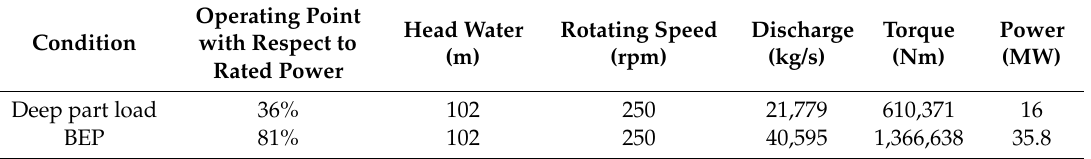
Table 1. Operating conditions simulated.